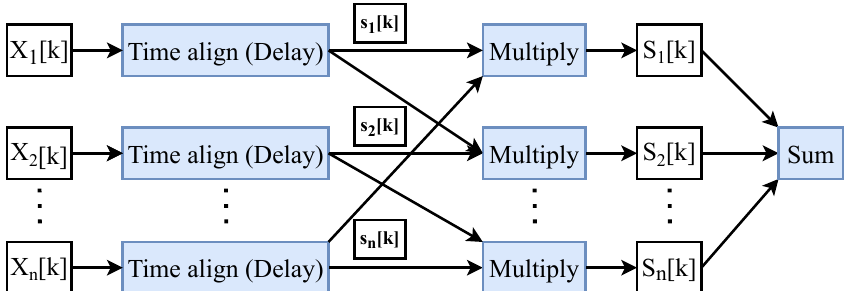
Figure 1. Block diagram for DMAS. The reflected signal is thoroughly delayed, multiplied in pairs and summed to calculate energy. The process is repeated for all input signals and integrated as a matrix of pixel values for image